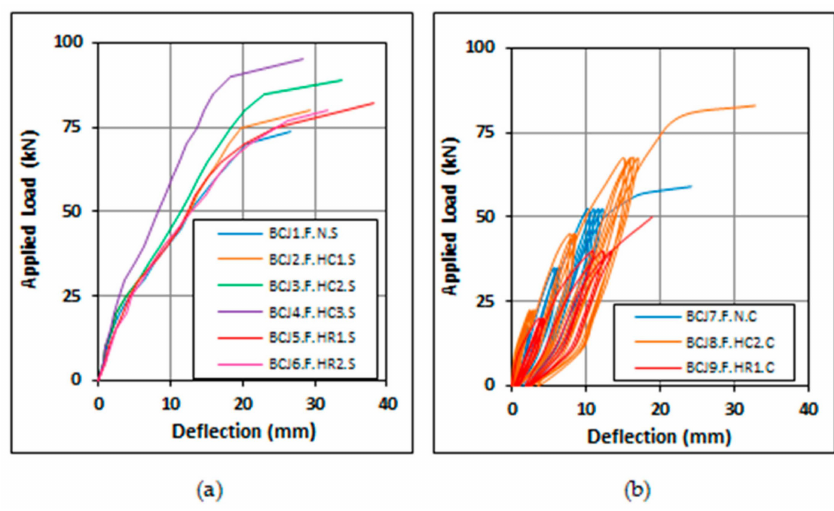
Figure 6. Load–deflection diagrams of all specimens. ( a ) Reference and hybrid specimens under static loads, ( b ) reference and hybrid specimens under cyclic loads (hysteresis loops).